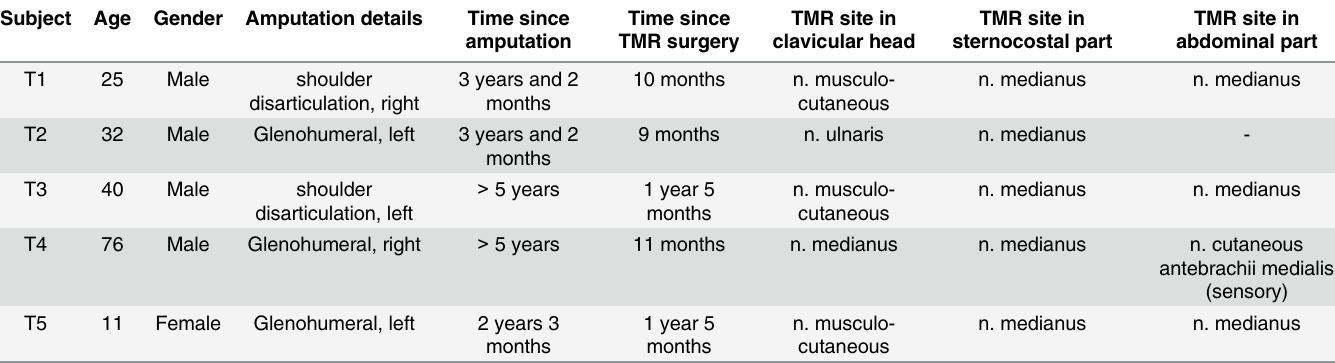
Table 1. Age, gender and amputation details of TMR